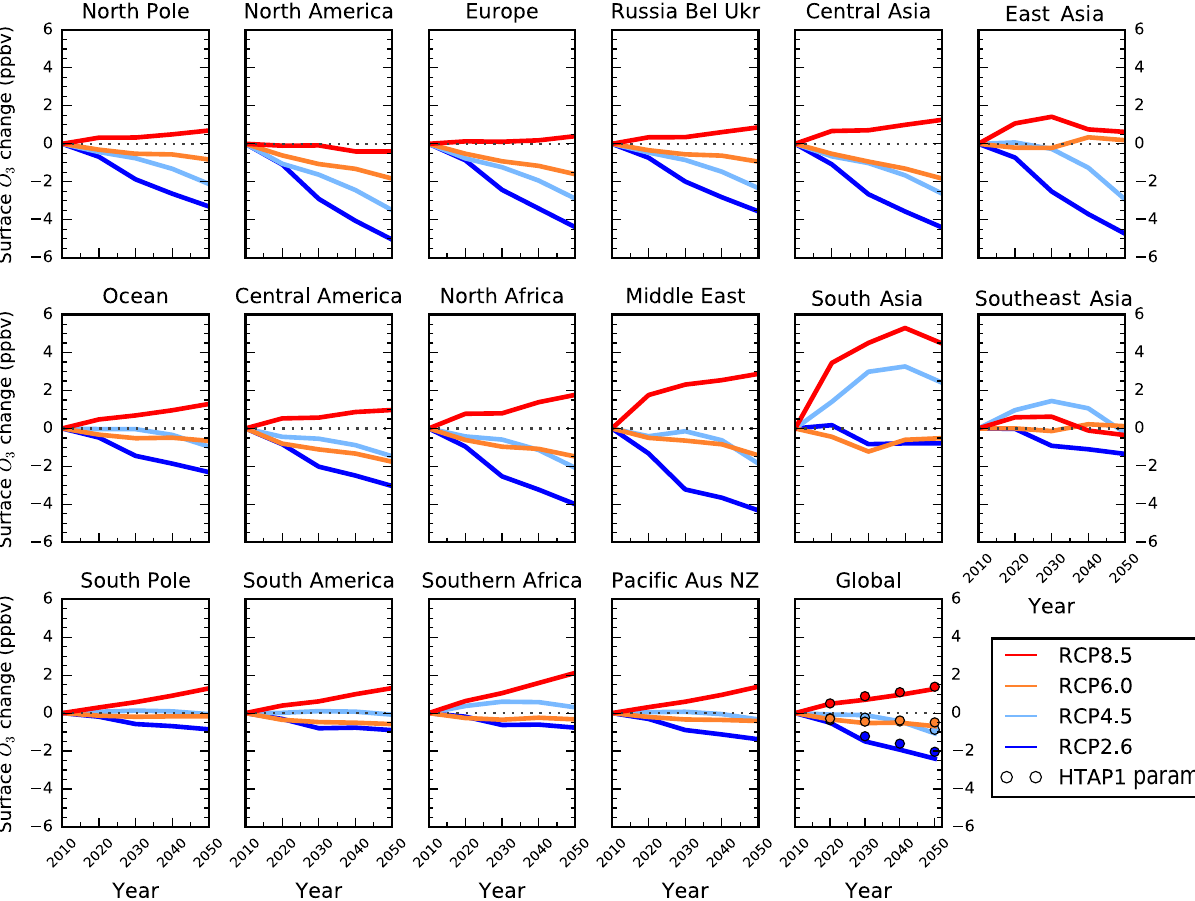
Figure 5. Annual mean regional surface O 3 changes between 2010 and 2050 from the parameterisation for the CMIP5 emission scenarios of RCP8.5 (red), RCP6.0 (orange), RCP4.5 (light blue) and RCP2.6 (blue). The global surface O 3 response from the parameterisation of Wild et al. (2012) for each scenario is represented as circles, but due to differences in regional definitions a straightforward comparison with TF-HTAP1 regions (Europe, North America, south Asia and east Asia) is not